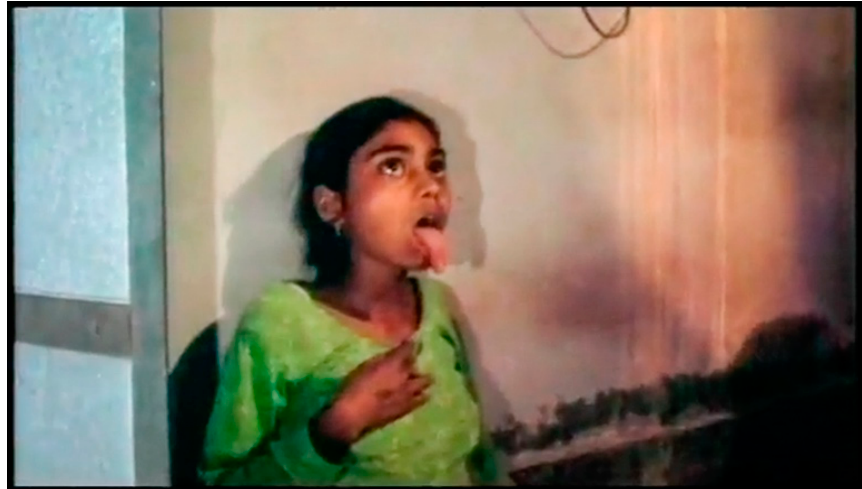
Figure 1. Kal ī possessing Kusum (Kusum 45:52). Figure 1. Kal¯ı possessing Kusum (Kusum